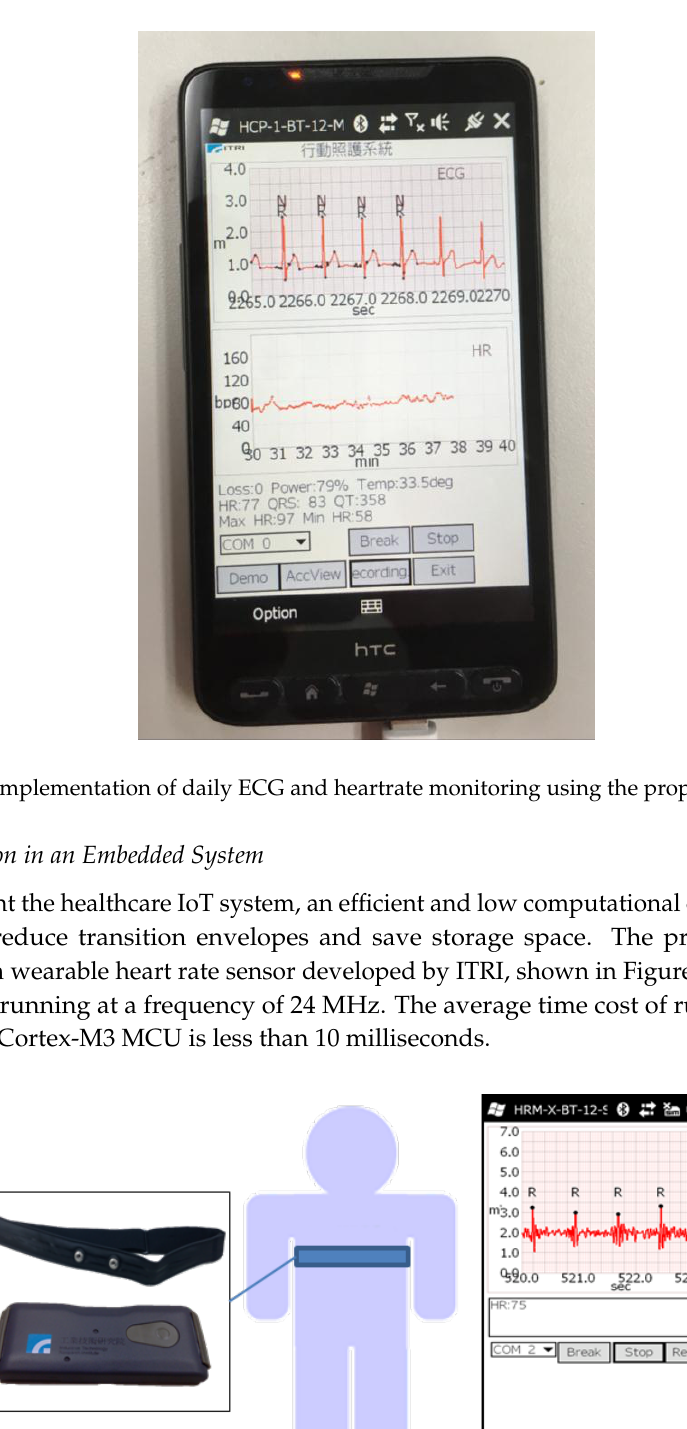
Figure 14. The graphic user interface and algorithm implementation for a mobile healthcare system.